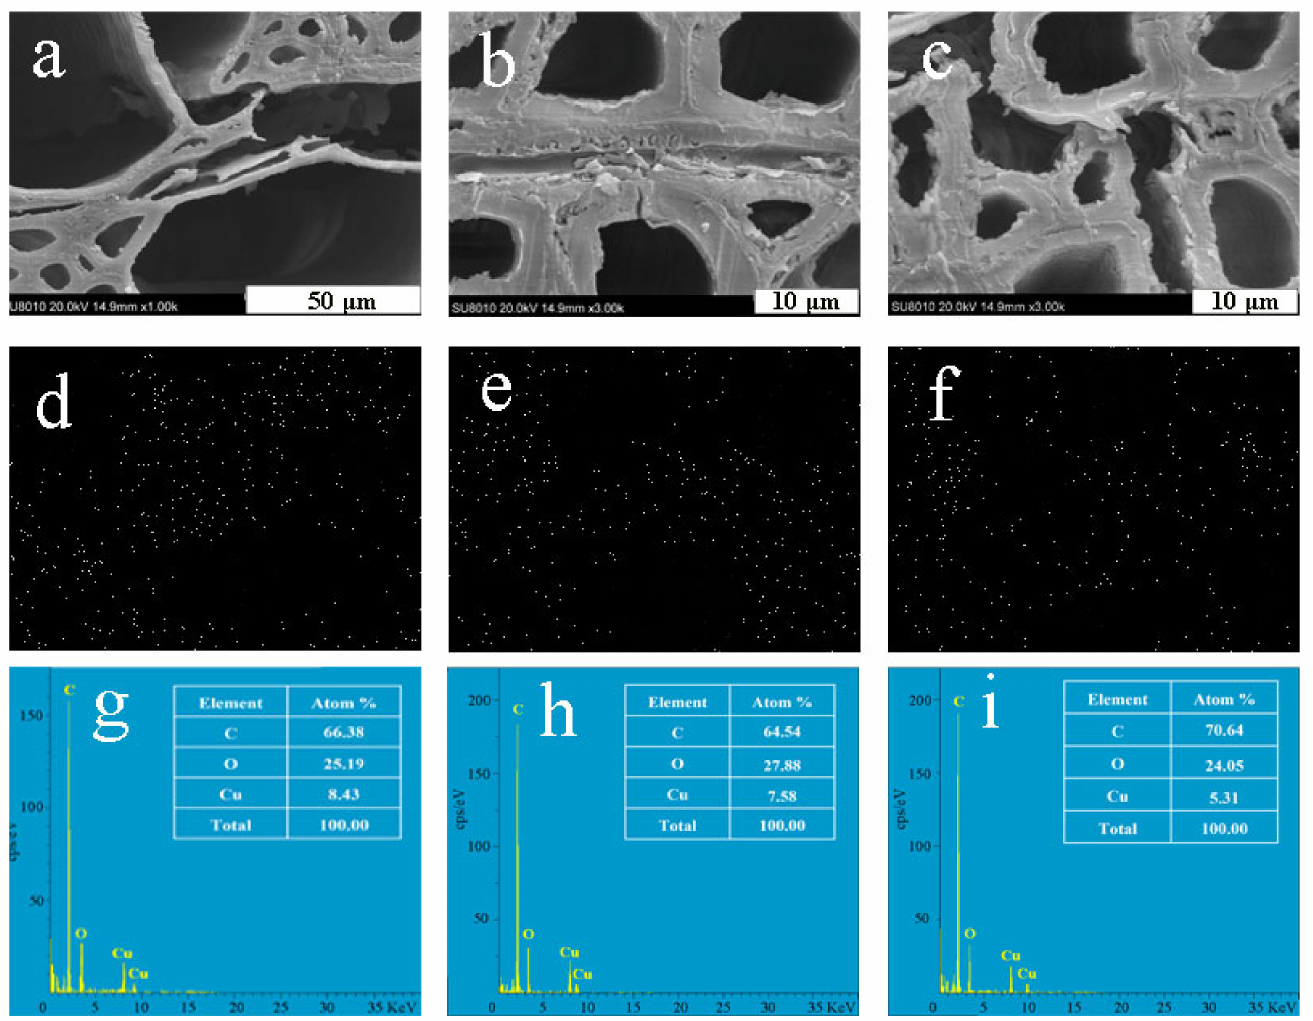
Figure 4. ( a – c ) SEM images, ( d – f ) copper elemental maps of cross-sections of wood fiber mats (( a ) vessels, ( b ) wood rays, and ( c ) fibers), and ( g – i ) EDS spectra and atomic percentage of each element